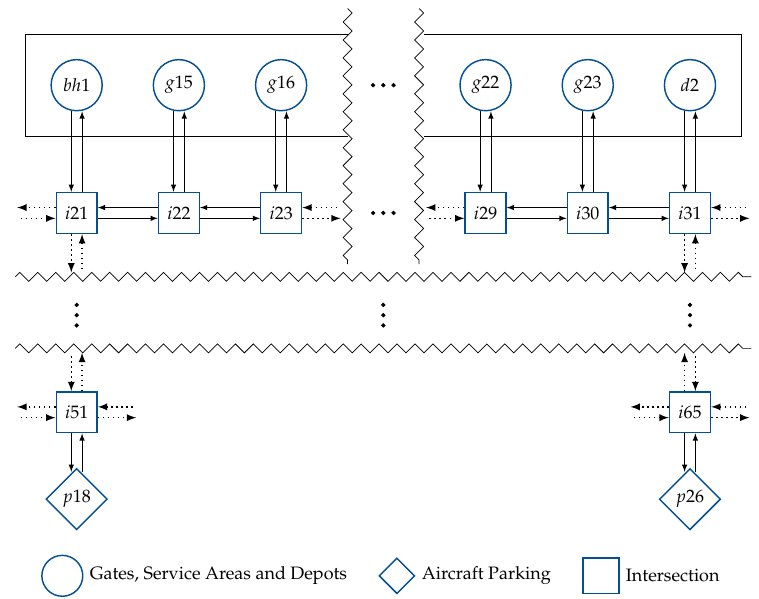
Figure 4. Representation of an airport as a planar